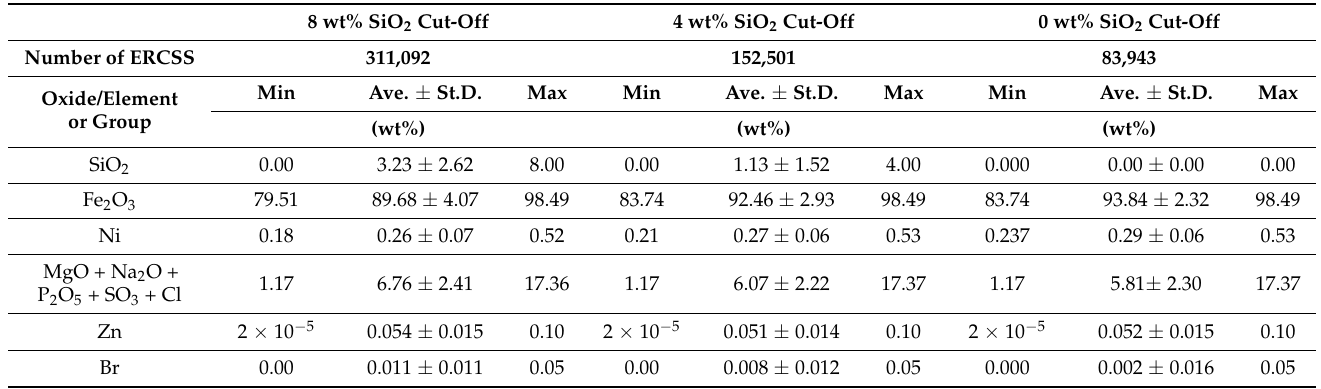
Table 8. Blueberry composition statistics over the largest group of ERCSSs, where this group is operationally fixed three times by three different cut-offs in SiO 2 weight percentage.